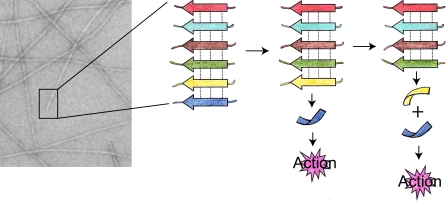
Schematic Representation of the Drug Action by Amyloids of GnRH AnalogsThe stable amyloid fibrils formed prior or shortly after subcutaneous injection and gradually release monomeric functional analogs at their termini. The EM picture shows amyloid fibrils of a long-acting GnRH analog. The end of a fibril is highlighted, and its structural composition of aligned peptides is schematically indicated. Each peptide colored individually in the fibril schematic interacts with neighboring peptides through intermolecular hydrogen bonds forming an “infinite” β-sheet along the fibril axis. This structural arrangement requires that peptides can be released only at the termini of the fibrils, which guarantees a controlled and slow release.